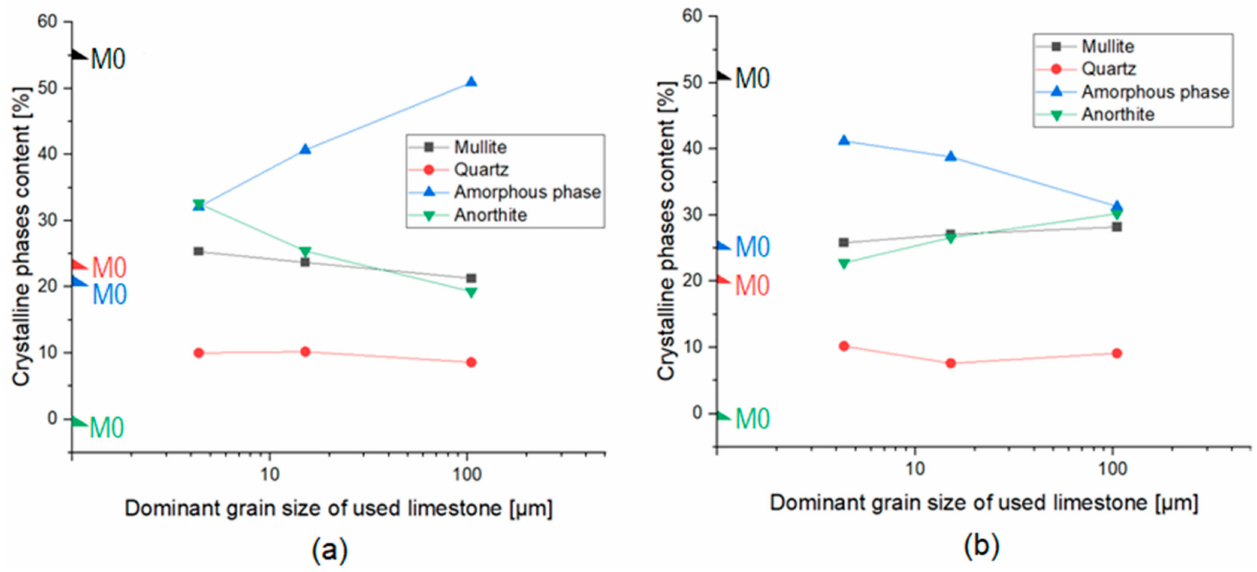
Figure 5. Phase composition analysis of materials fired at: ( a ) 1160 ◦ C and ( b ) 1180 ◦